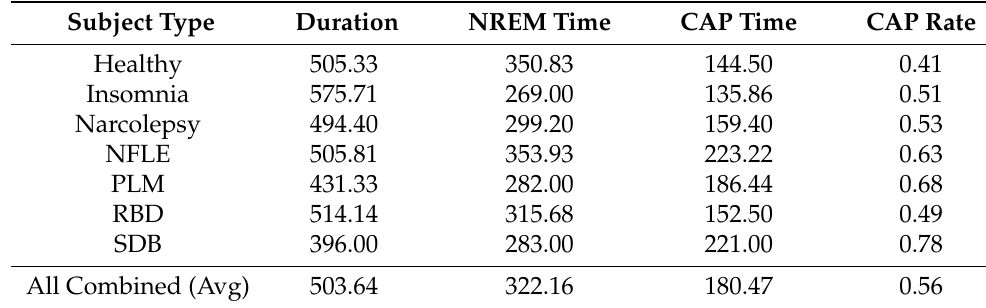
Table 14. Details of sleep microstructure for subjects used in this study.